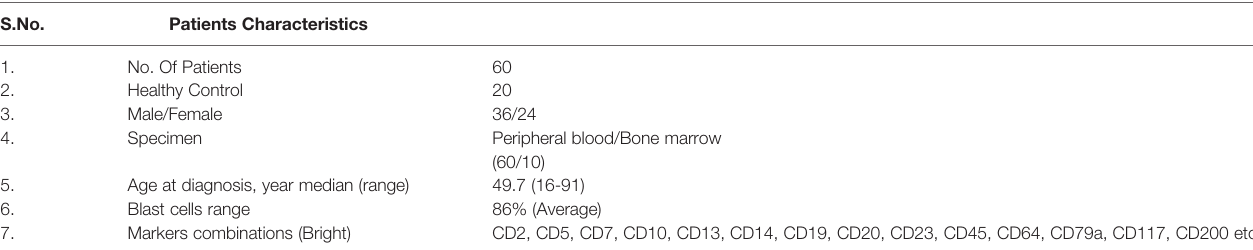
TABLE 1 | Overview of clinical characteristics of CML patients.